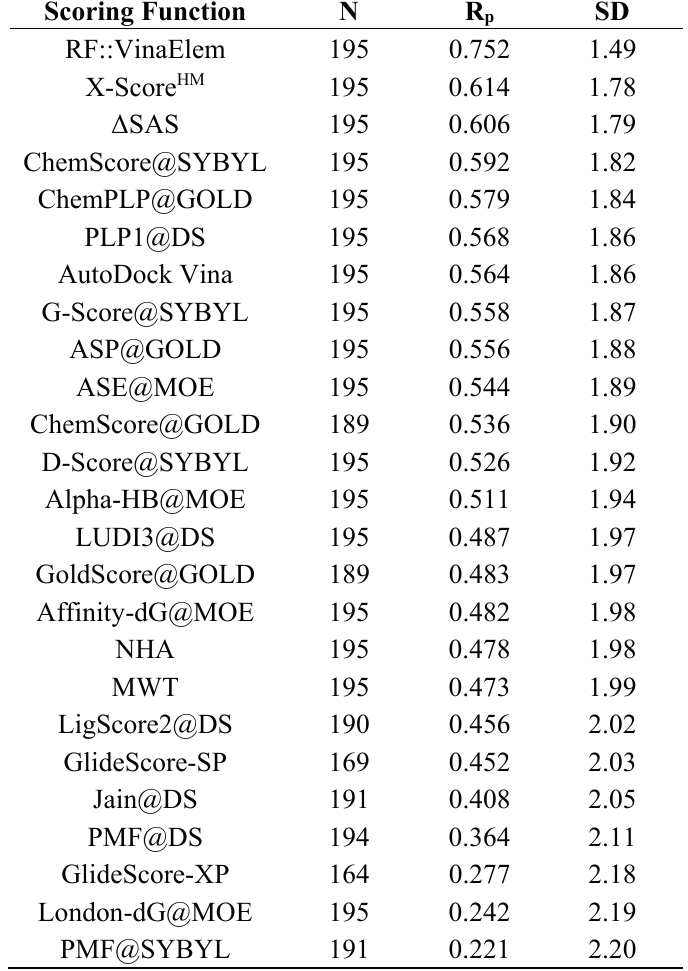
Table 2. Performance of 22 scoring functions and 3 baselines on PDBbind v2013 core set ( n =